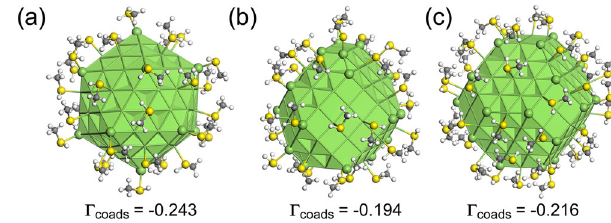
Fig. 2 Illustration of silver nanoparticles covered by a shell of chemisorbed methanethiol molecules (model contaminants) at similar coverages on different structures, according to density functional theory (DFT) optimisations. a Regular icosahedron Ag147ico (Icosahedral symmetry, diameter Ø = 1.66 nm, θ = 0.35 ML, 32 contaminant molecules), b Strongly irregular truncated octahedron Ag147sito (Face- centred cubic, C1 symmetry, Ø = 1.70 nm, θ = 0.33 ML, 32 contaminant molecules) and c Regular truncated octahedron Ag201rto (Face-centred cubic, Oh symmetry, Ø = 1.80 nm, θ = 0.36 ML, 44 contaminants). Adsorption energies Γ coads , are expressed in J m − 2 . The colour labels for atoms are silver in green, sulphur in yellow, carbon in grey and hydrogen in white. In the silver nanoparticles, the vertices are represented by balls, whereas the bonds between silver atoms belonging to facets and edges are depicted by joint sticks. ML means